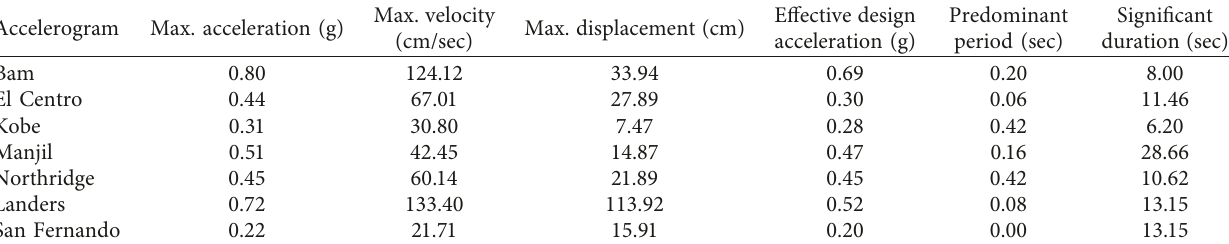
Table 3: Original earthquakes’ specifications.